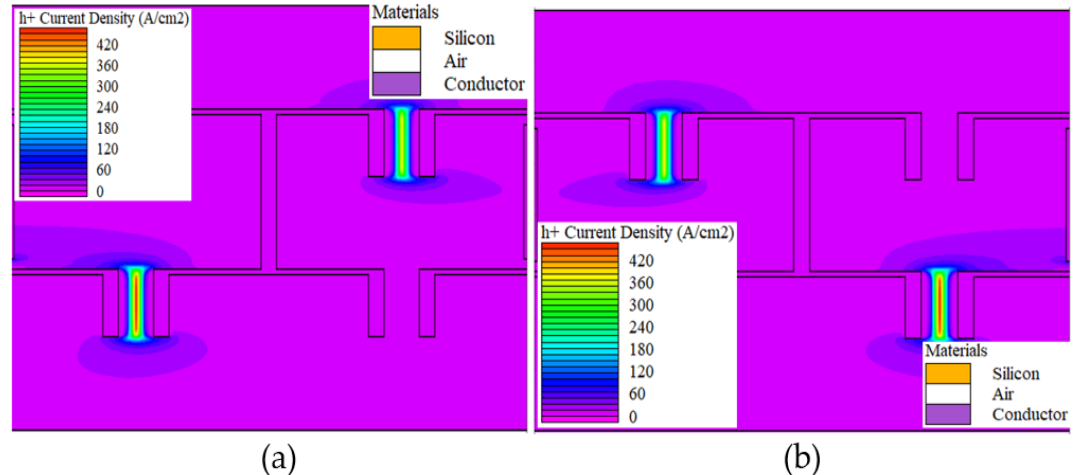
Figure 6. ( a , b ) The hole current density of the SOI SSD full wave bridge rectifier.